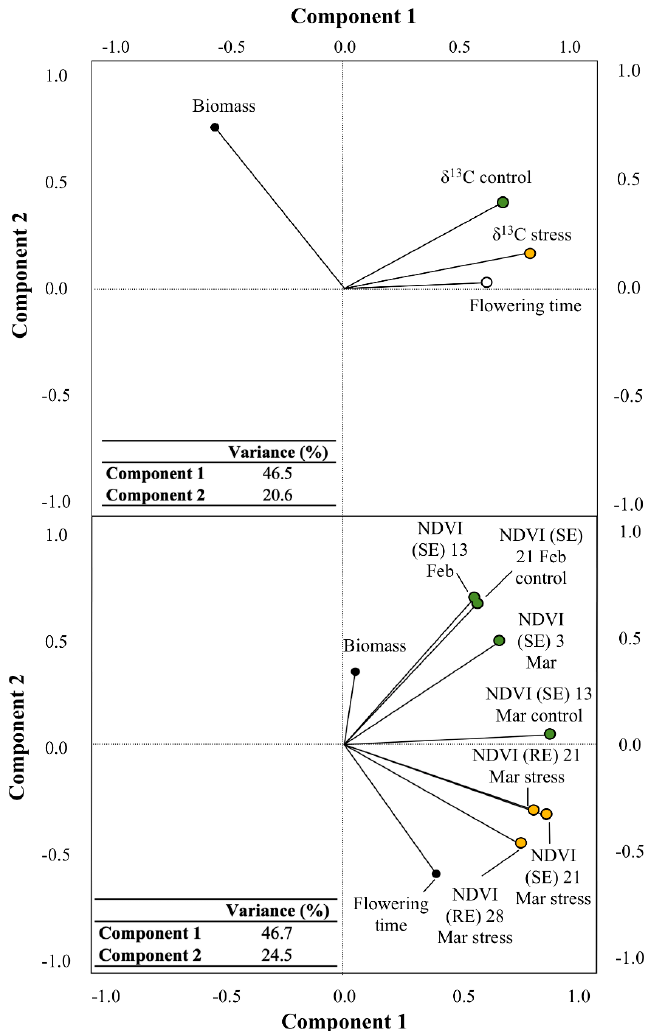
Figure 2. Analysis of principal components (PCA) showing similarity and relationship between biomass, flowering time, and the stable carbon isotope composition ( δ 13 C) of the flag leaf dry matter sampled before ( δ 13 C control) and after ( δ 13 C stress) drought conditions were imposed in the field (upper panel), and biomass, flowering time, and the Normalized Difference Vegetation Index (NDVI) using Sequoia (SE) and RedEdge (RE) sensors and flowering time (lower panel) measured in the 248 EDP on different days after planting. The percentage of variance by the two first axes (components 1 and 2) is included as an inset within each panel.